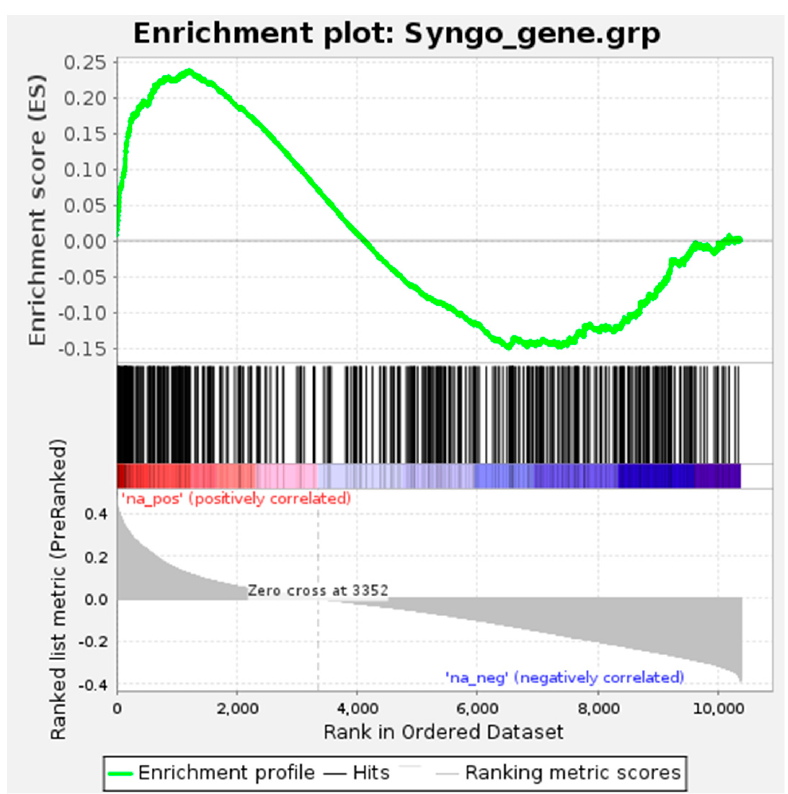
Figure 6. Significant enrichment of synaptic genes in the ranked list of candidate RNAs. The list of 10,377 brain-expressed RNAs was ranked by the mean probability scores predicted by the SVM, ANN, and RF models using the full set of expression features. The GSEAPreranked analysis [51] was then performed for a set of 1112 human synaptic genes obtained from the SynGO database [50]. The enrichment score (ES) reaches the maximum (0.2373) near the top of the ranked list, and the nominal p -value is estimated to be zero by an empirical phenotype-based permutation test procedure (actual p -value < 0.001 with 1000 permutations).